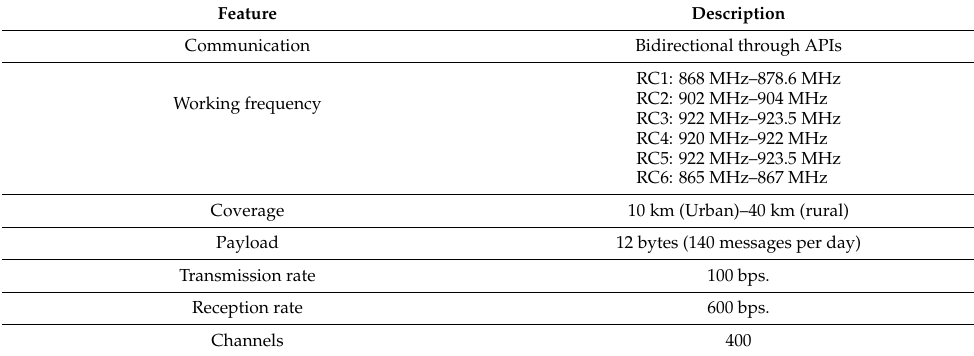
Table 3. Main characteristics of Sigfox [21,22].